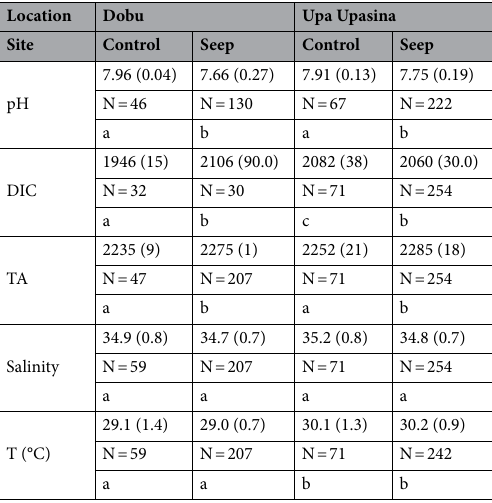
Table 1. Means and standard deviation (in parenthesis) of the investigated environmental parameters in seep and control sites in Dobu and Upa Upasina. Lettering indicates significantly different groups